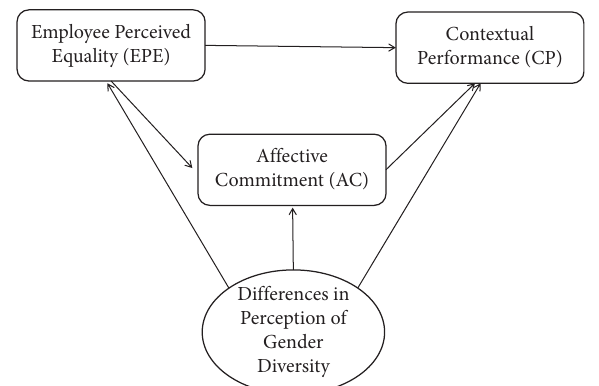
Figure 1: Theoretical